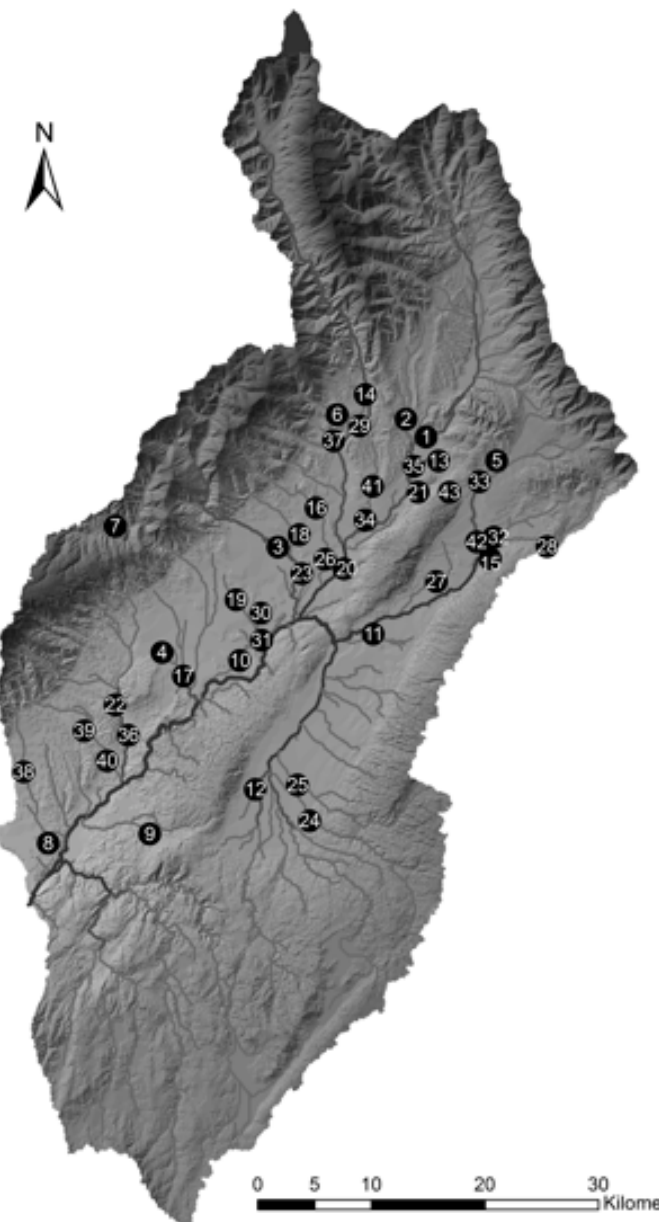
Figure 1. Locations of the 43 study sites in the Manuherikia River catchment.